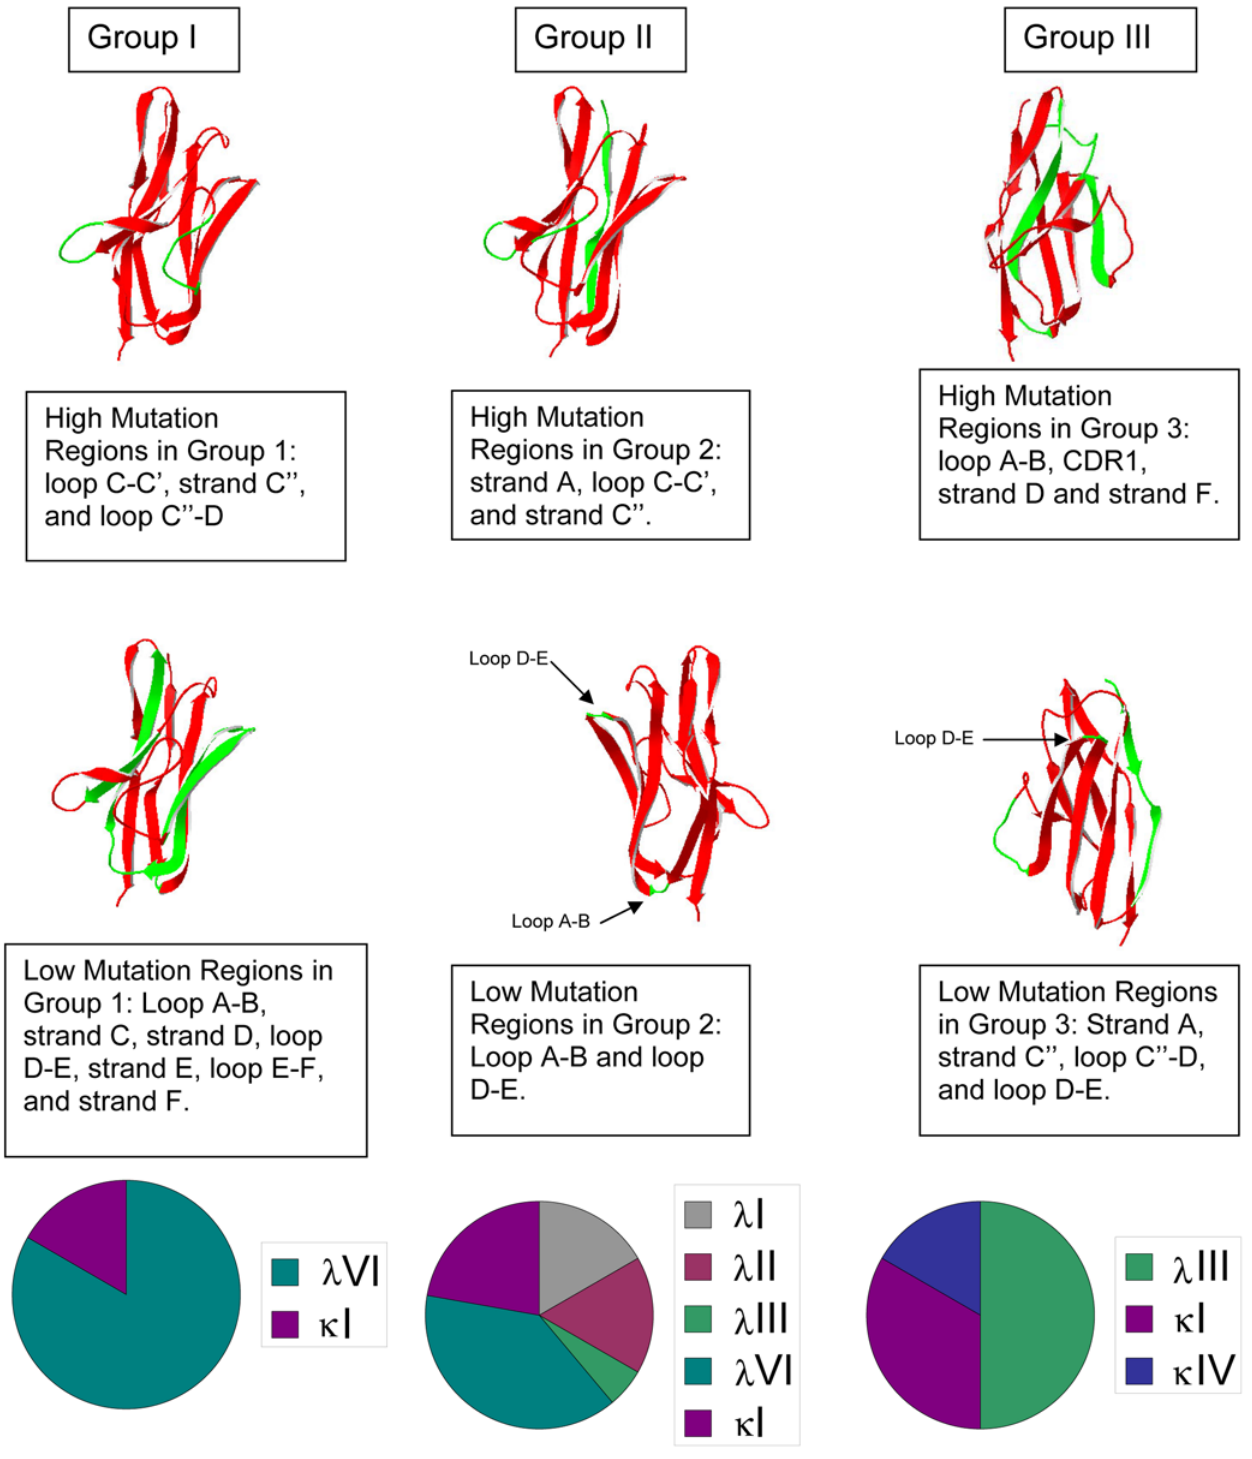
Figure 6. Structural models showing regions of high and low non-conservative mutation accumulation in iFLC level groups. Protein models were based on the crystal structure for V l VI germline (2CDO.pdb). The b -strands in the structure are shown as red ribbons; mutation regions discussed in the captions are shown in green.